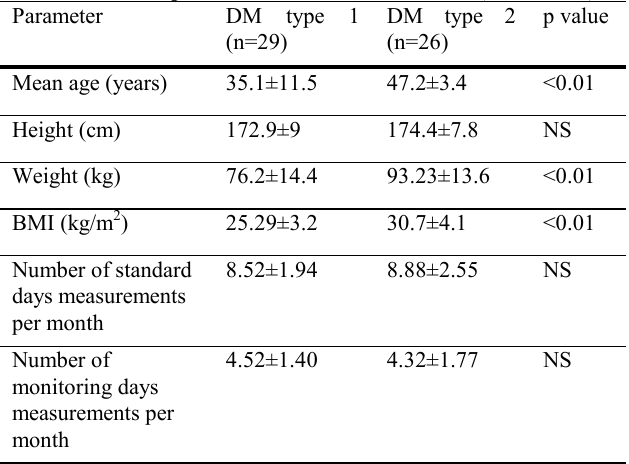
Table 1. Description of baseline characteristics (mean ± SD)